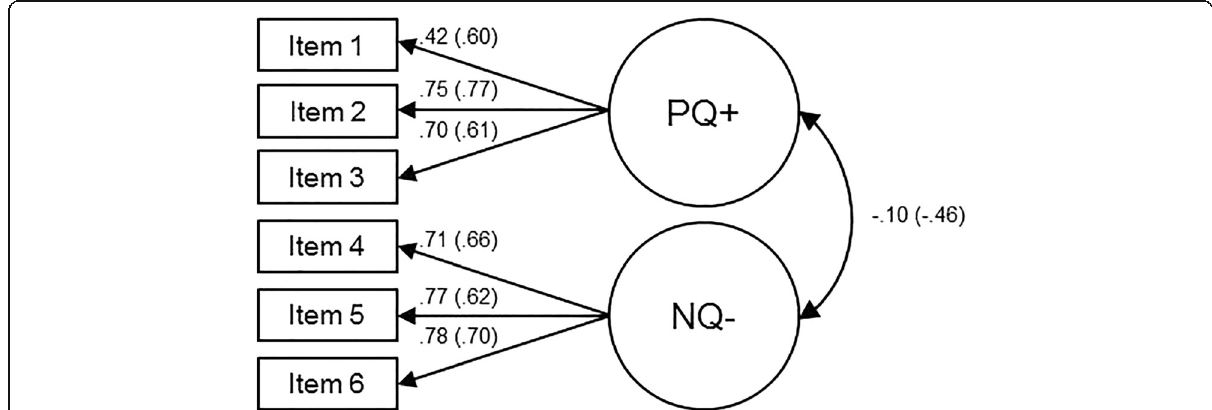
Fig. 1 Two-dimensional measurement model of the KSE-G with standardized coefficients. The coefficients of the German sample are in